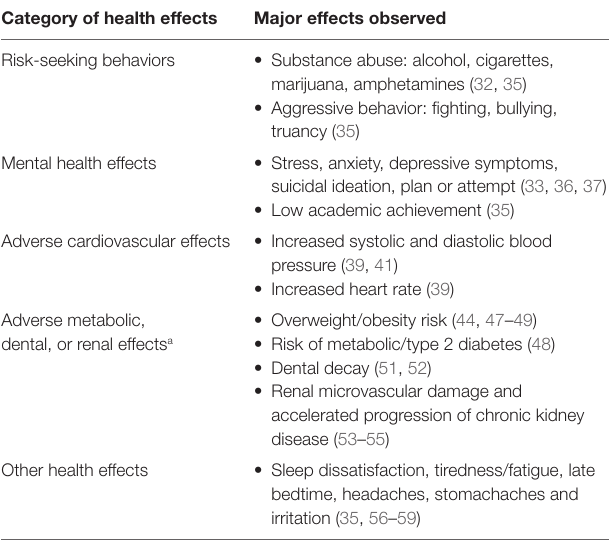
TAble 1 | Summary of negative health effects of energy drinks